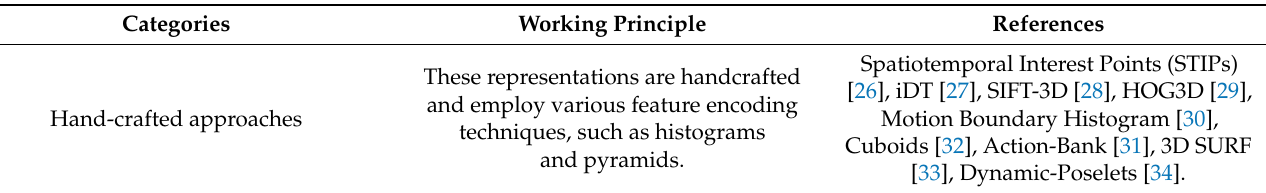
Table 2. Different categories of approaches of video